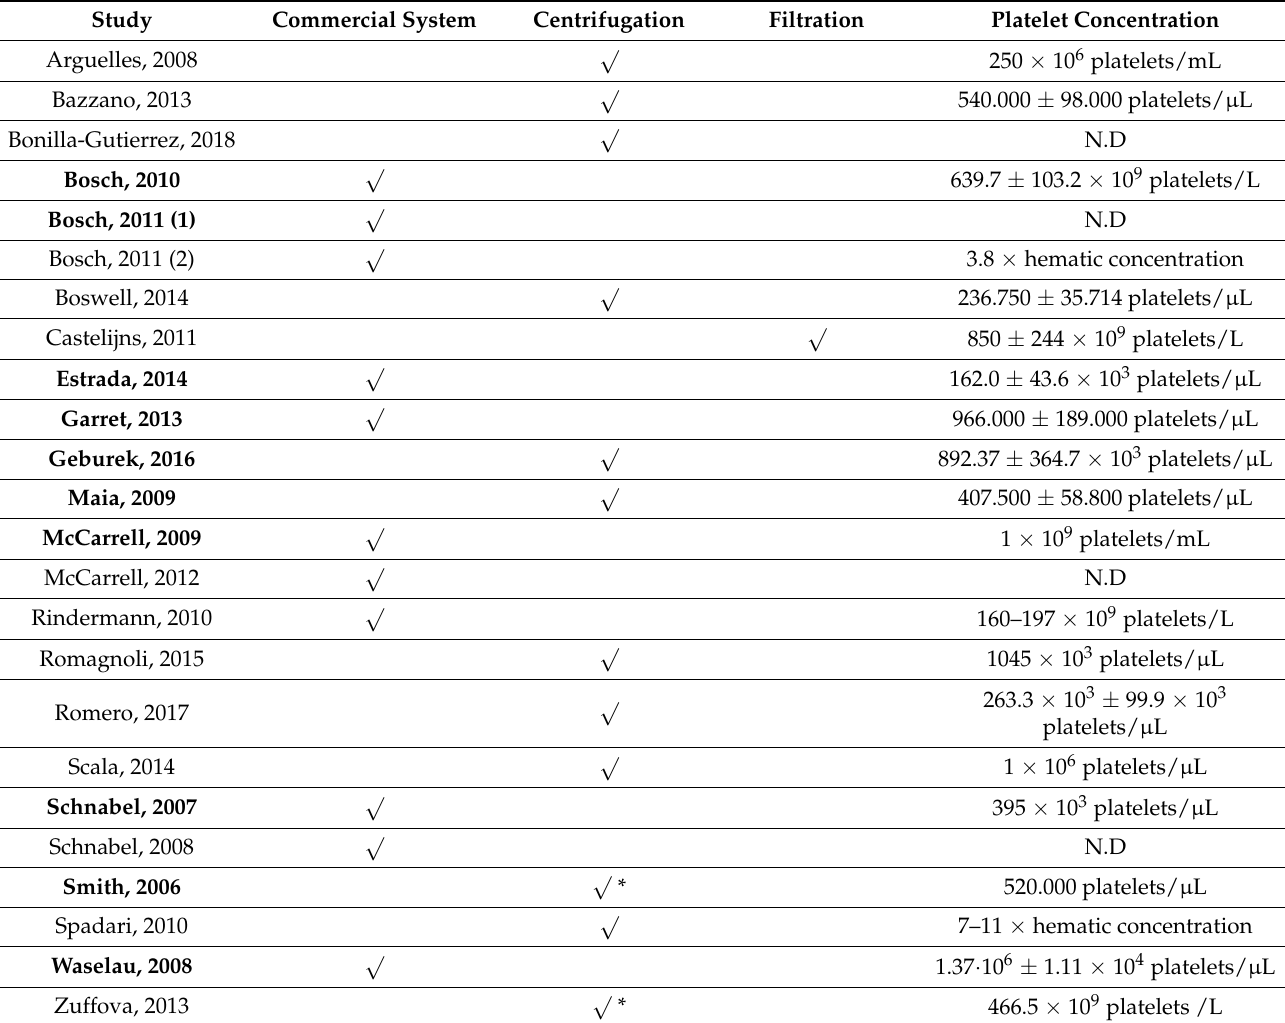
Table 2. Techniques used for platelet-rich plasma (PRP) preparation and final platelet concentration in the studies included in the systematic review. In bold the studies included in the meta-analysis.